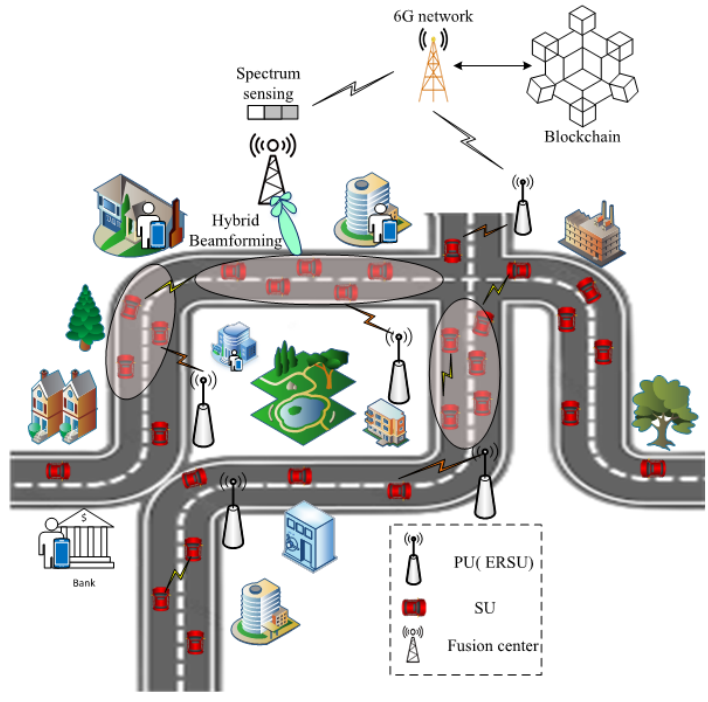
Figure 6. Use-case